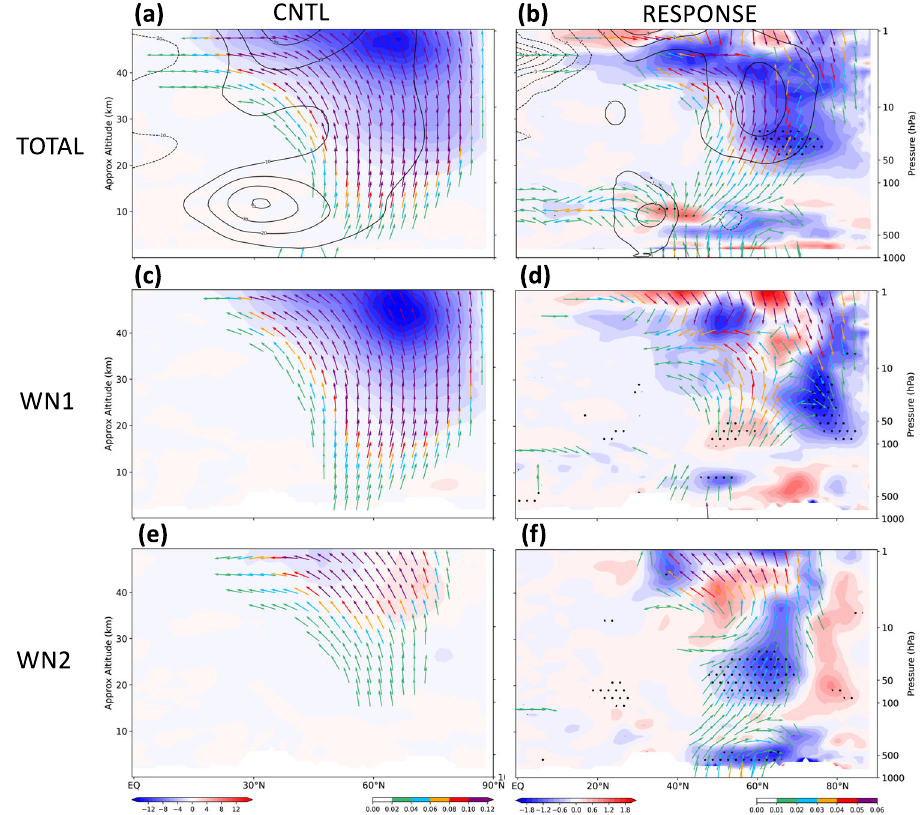
Fig. 4 Planetary wave EP fl ux. Zonal-mean zonal wind (line contours; in m s − 1 ), EP Flux anomaly (vector; in m 2 s − 2 ), and divergence anomaly ( fi lled contours; in m s − 1 day − 1 ) in CNTL (left column), and response (right column) for all wavenumbers ( a – b ), WN1 ( c – d ), and WN2 ( e – f ) averaged from day − 10 to day − 1 prior the onset. Stippling indicates statistically signi fi cant regions of divergence ( fi lled contours in b , d , f ) at the 95%